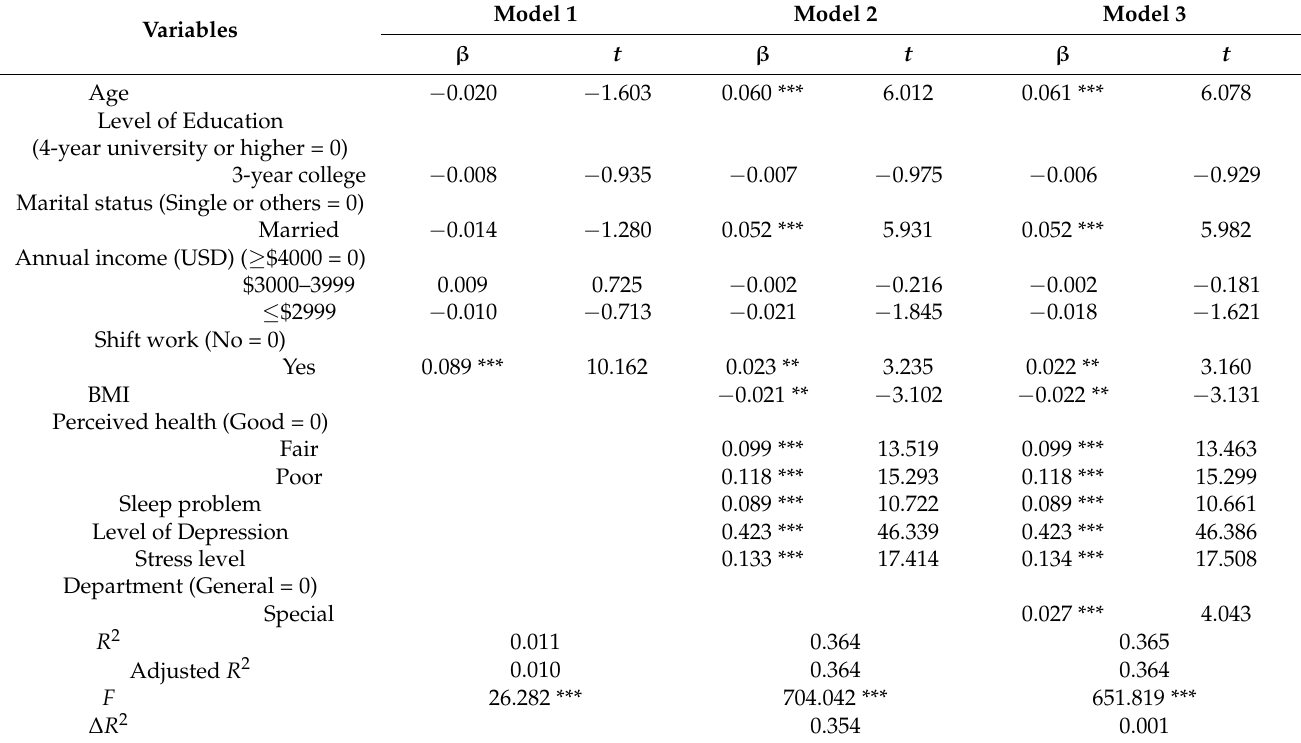
Table 3. Hierarchical multiple regression analysis predicting mental fatigue ( N =